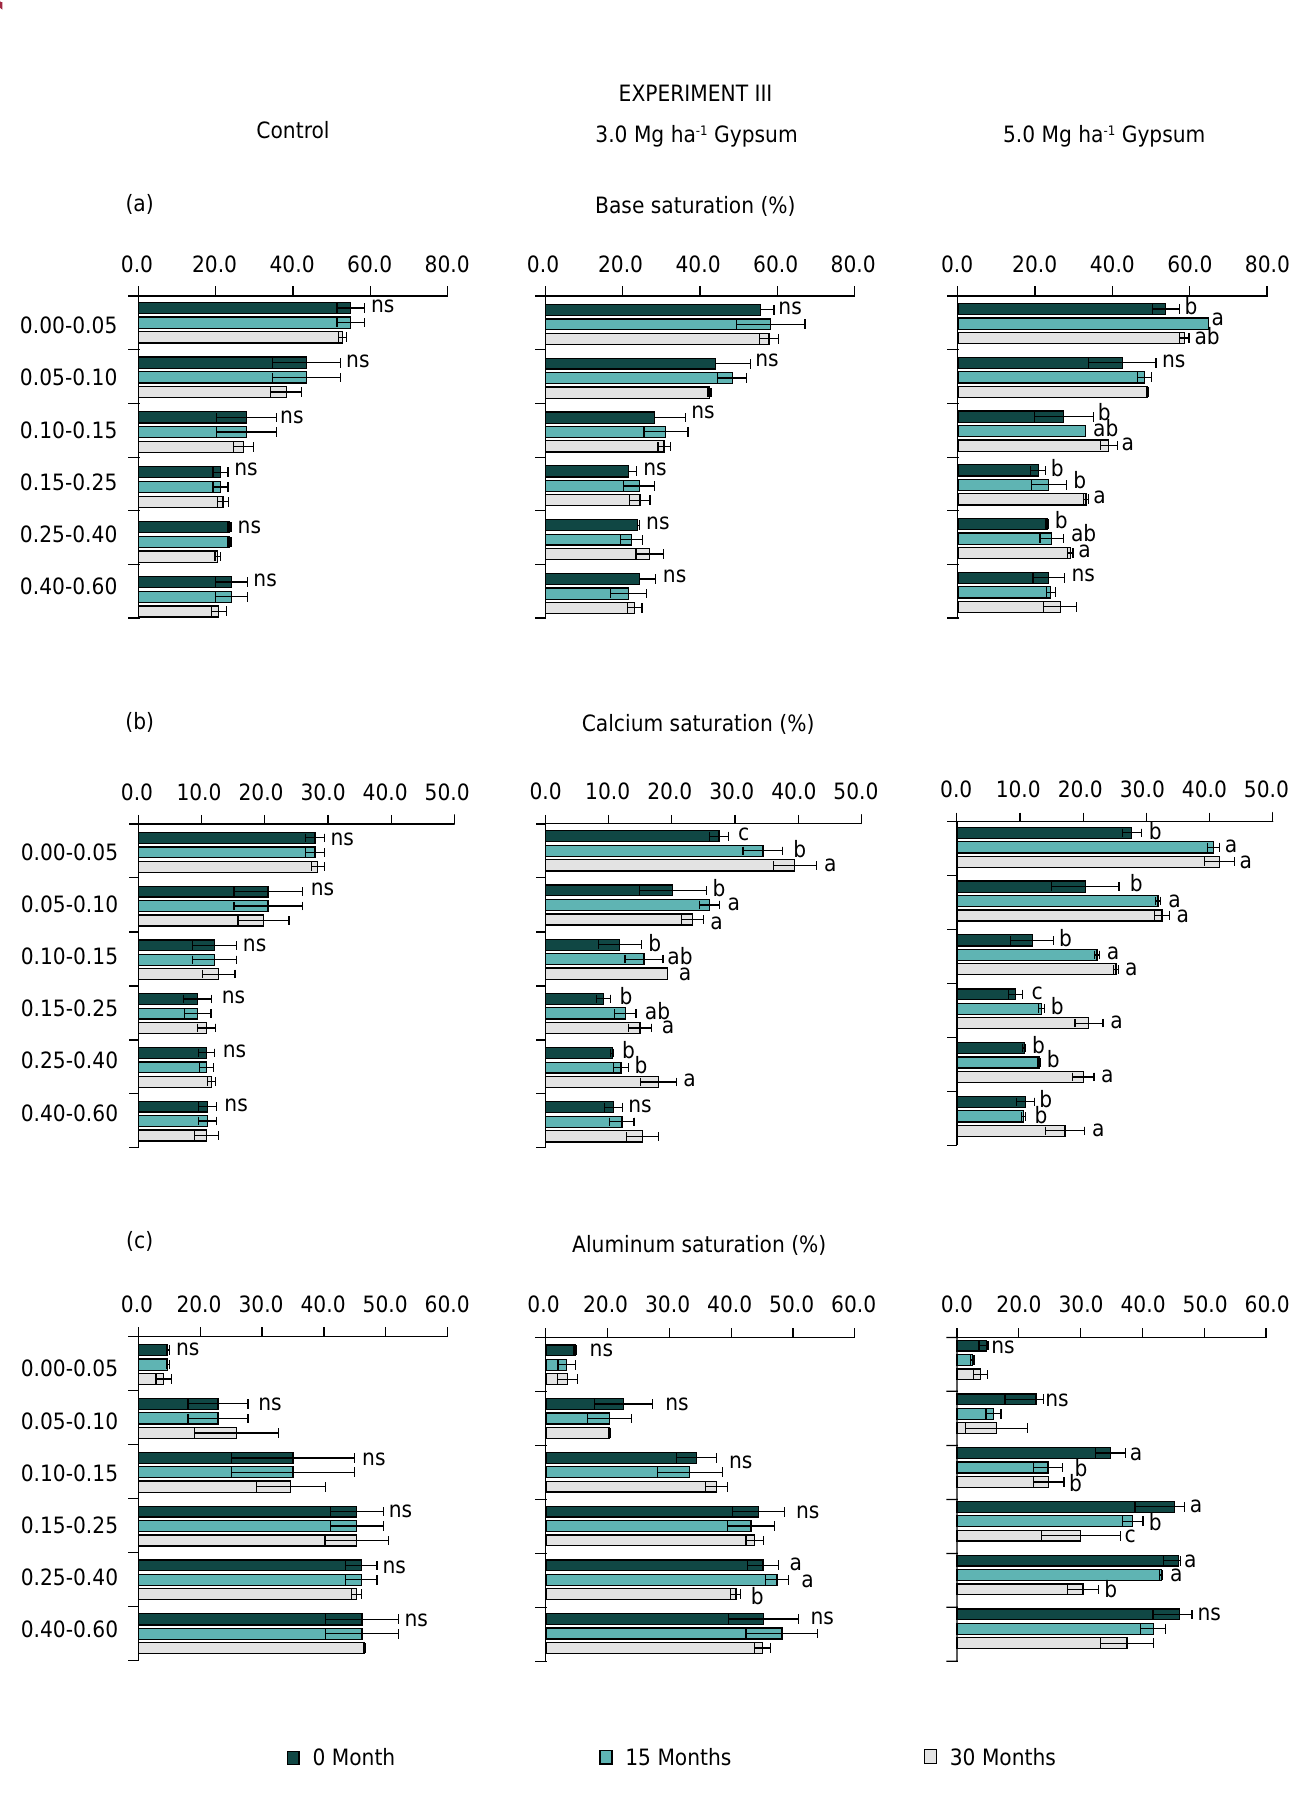
Figure 5. Time effect of the rates of 0.0, 3.0, and 5.0 Mg ha -1 of gypsum on calcium saturation (a), base saturation (b), and aluminum saturation (c) for Experiment III. ns : not significant at 5 % probability of error; the same letters on the bars for the same depth do not differ significantly at 5 % probability of